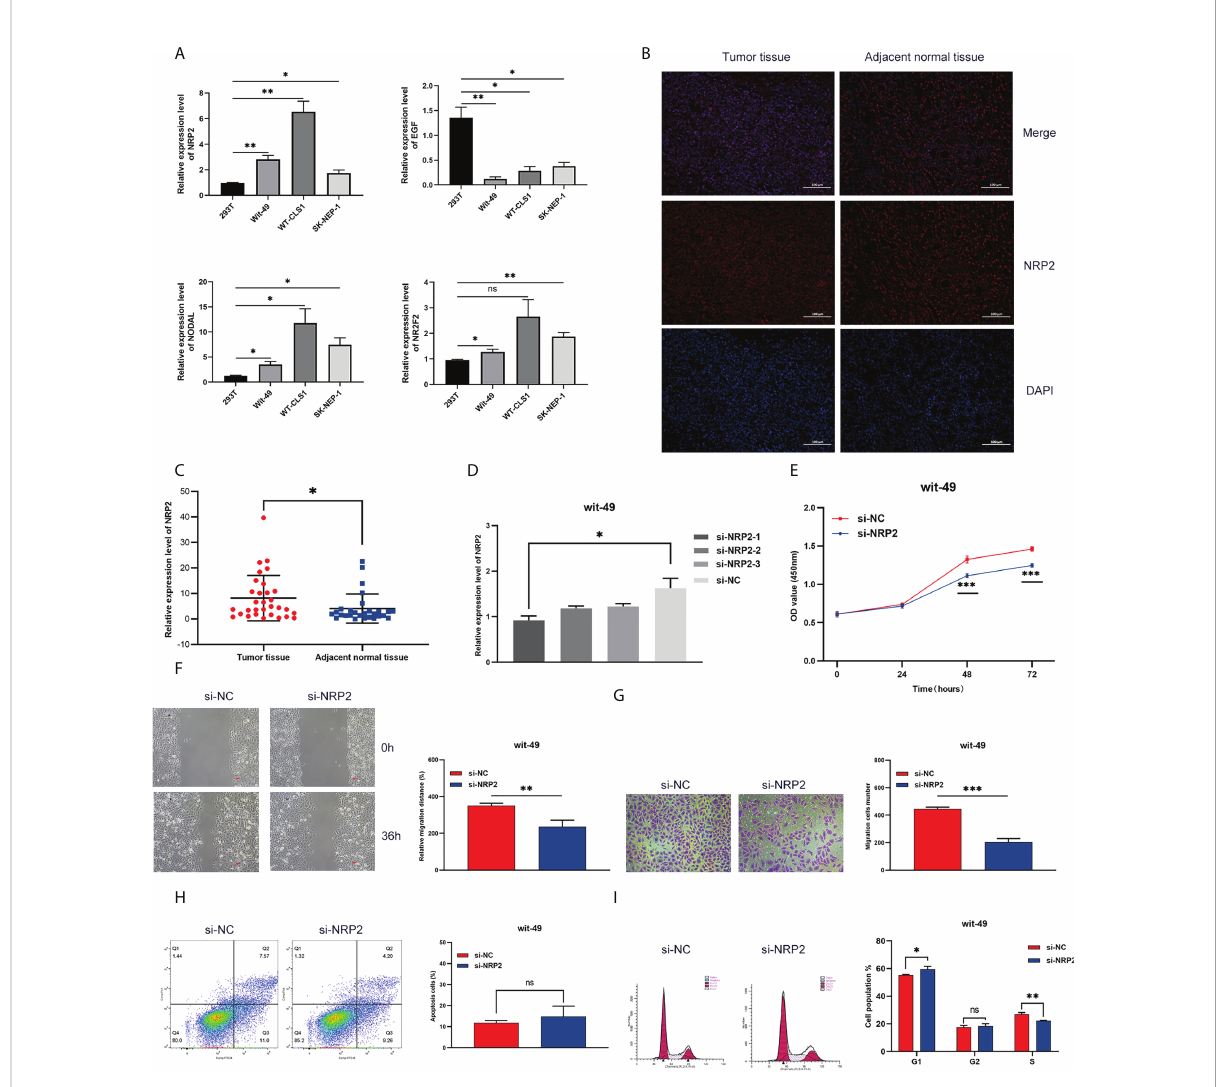
FIGURE 8 Expression and functional validation. (A) The mRNA expression of NRP2, EGF, NODAL, and NR2F2 in different Wilms tumour cell lines. (B) The difference in NRP2 expression patterns was con fi rmed by immuno fl uorescence staining in tumour tissue and non-tumour tissue. (C) The expression level of NRP2 in tumour tissue and non-tumour tissue. Results were analyzed by unpaired t-test. (D) qRT-PCR analysis of NRP2 expression in wit-49 cells after transfection with siRNA. (E-G) The proliferation, migration, and invasion of wit-49 cells by the CCK-8 assays, wound healing assays, and transwell assays. (H, I) Cell cycle phase distribution and cell apoptosis rate were determined by fl ow cytometry. *, **, and *** indicate a signi fi cance level of 0.05, 0.01, 0.001, respectively; and ns indicate no signi fi cant